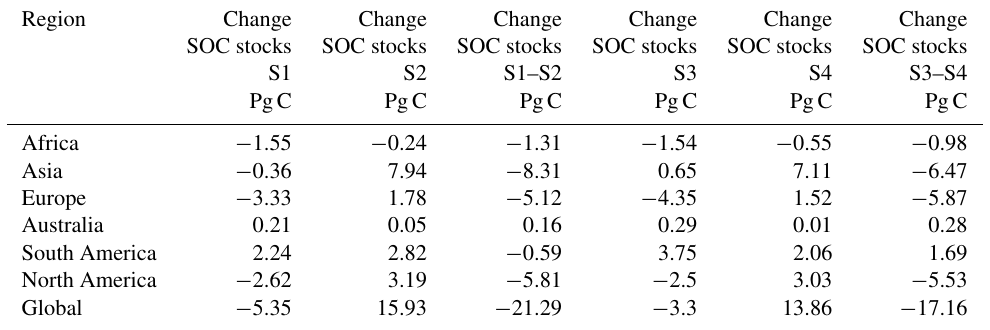
Table 4. Model estimates per continent of changes in SOC stocks since 1851 from simulations S1, S2, S1–S2, S3, S4, and S3–S4. Region Change Change Change Change Change Change SOC stocks PgC PgC PgC PgC Africa